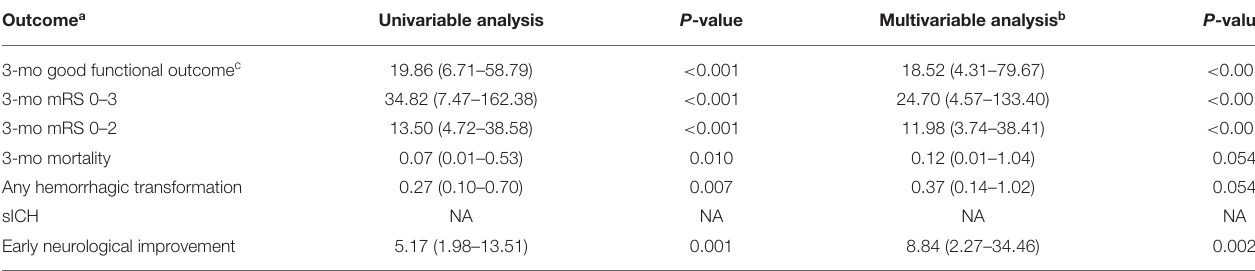
TABLE 3 | Associations between the corticospinal tract salvage and clinical outcomes.